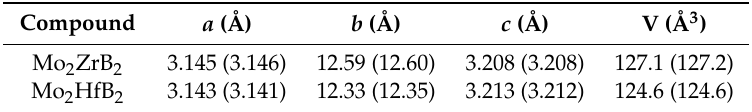
Table 1. Lattice parameters a , b , c and volumes of Mo 2 ZrB 2 and Mo 2 HfB 2 as calculated with CP2k (Quantum ESPRESSO).